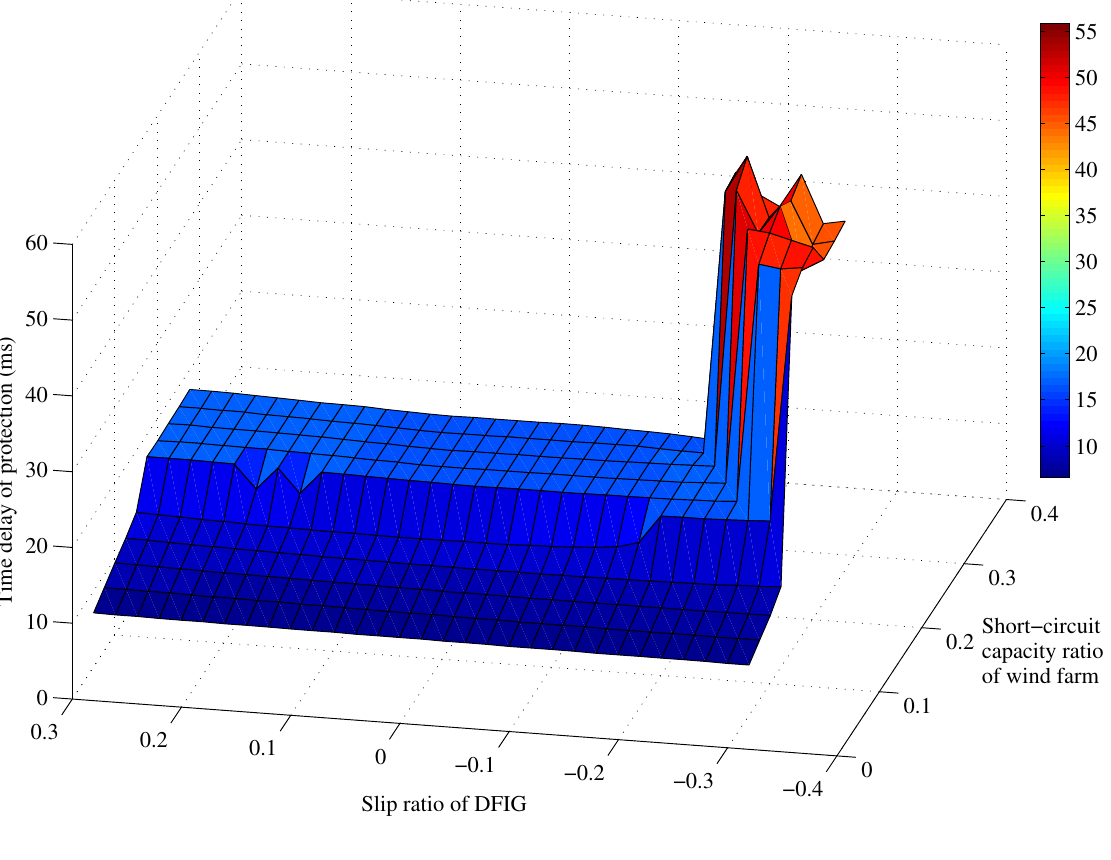
Figure 13. Time delay of the protection with the setting value of K selected as 0.15.